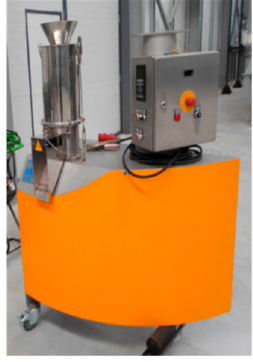
Figure 2. The pelleting press.